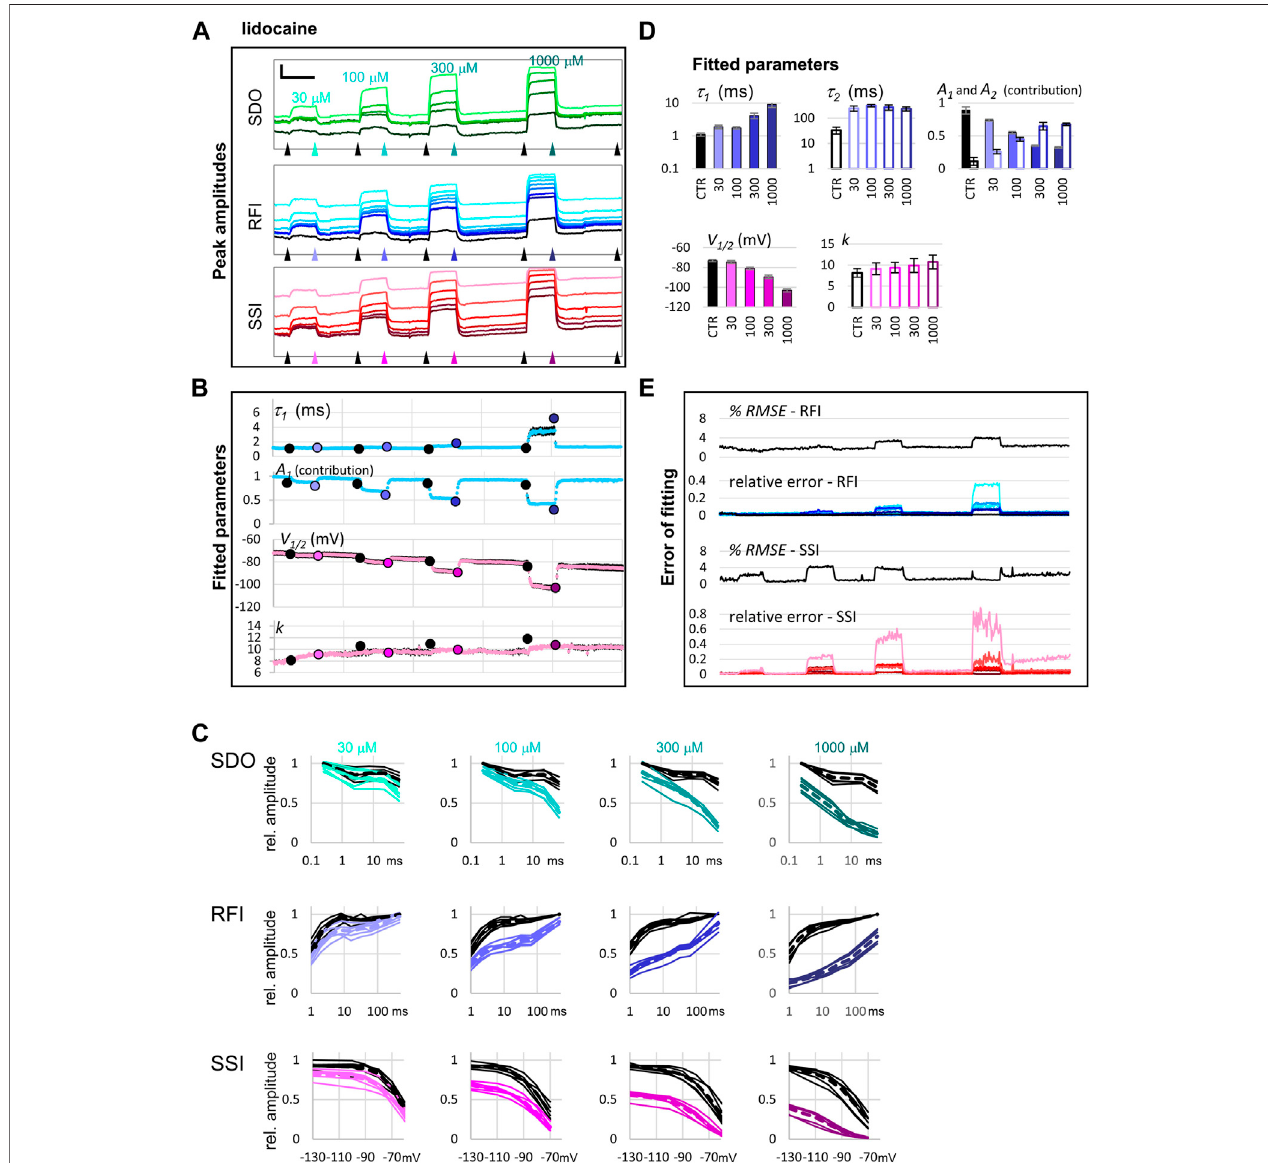
FIGURE5| Theeffectoffourdifferentconcentrationsoflidocaineonpeakamplitudes. (A) Anexampleofpeakamplitudeplotsforall17pulse-evokedcurrents, groupedintothe SDO , RFI ,and SSI groupsasshownin Figure2 .Scalebars:2 nA,50 s.Arrowheadsindicatethetimepointsimmediatelybefore,andattheendof drug perfusion periods. At each point, indicated by the arrowheads, the average of three consecutive data points was taken to construct the plots shown in panel (C) . (B) ParametersofBoltzmann, and bi-exponentialautomated fi tsthroughout thefour drugapplication periods.Colored circles indicatethevalues obtained by visually controlled fi tting of n (cid:2) 6 curves; the same data that is shown in panel (C) . (C) Reconstructed SDO , RFI , and SSI plots for n (cid:2) 6 cell ensembles. Colors matchthecolorsofarrowheadsinpanel (A) .Dottedlinesshowtheaverageofthesixcellensembles. (D) Parametersobtainedbyvisuallycontrolled fi ttingofRFIand SSI plots. (E) The error of fi tting throughout the four drug application periods. RMSE values are expressed as the percentage of the peak amplitudeevoked by pulse #1 of the same sweep. Relative errors are shown for pulses #6 – #12 and #1 (shades of blue and black, as shown in panel (A) ), as well as for pulses #12 – #17 (shades of red, as shown in panel (A)